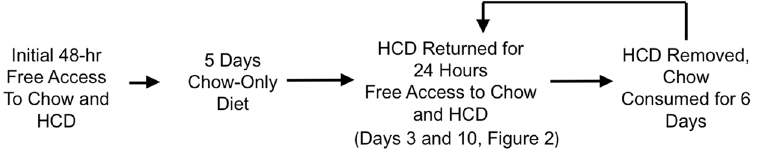
Figure 1. Diagram describing the intermittent feeding paradigm that was used to produce binge-like food intake (modified from Czyzyk et al . 9 ). Animals in the Intermittent access group first had 48 hr. access to both HCD and chow, after which time, HCD was removed and animals were maintained on chow. Following this period, HCD was reintroduced for 24 hr. Intake was then measured at 3 hr and 24 hr following HCD reintroduction (Fig. 2I–L, Intermittent exposure as presented on the x-axis at “day 3”). Following the initial intermittent exposure period, HCD was then removed and animals were fed chow for 6 days. Following this 6 day period, HCD was returned for 24hrs for a second time (Fig. 2I–L, intermittent exposure as presented on the x-axis at “day 10”). Data from this second intermittent HCD exposure episode are used for all reported